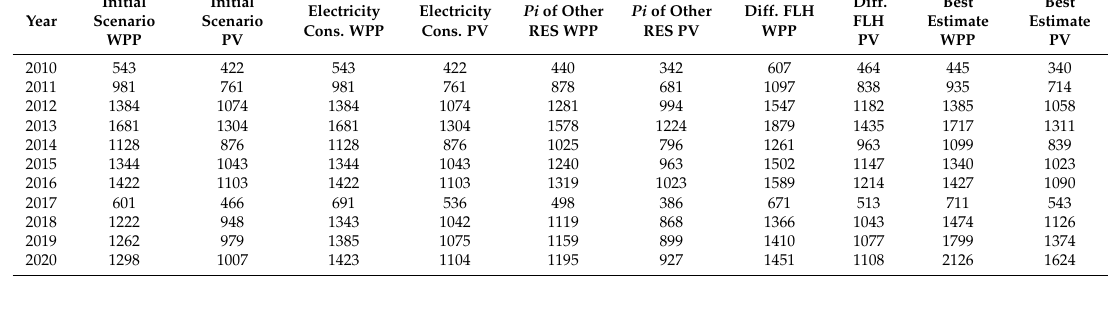
Table 9. Pi of WPP and PV in different scenarios.